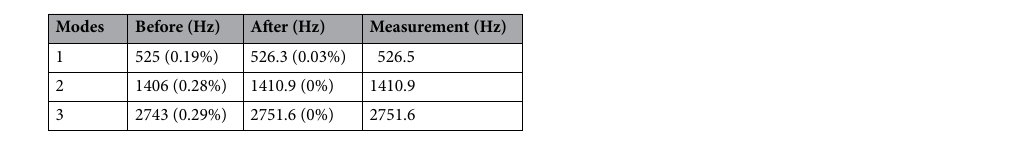
Table 4. Natural frequencies before and after model